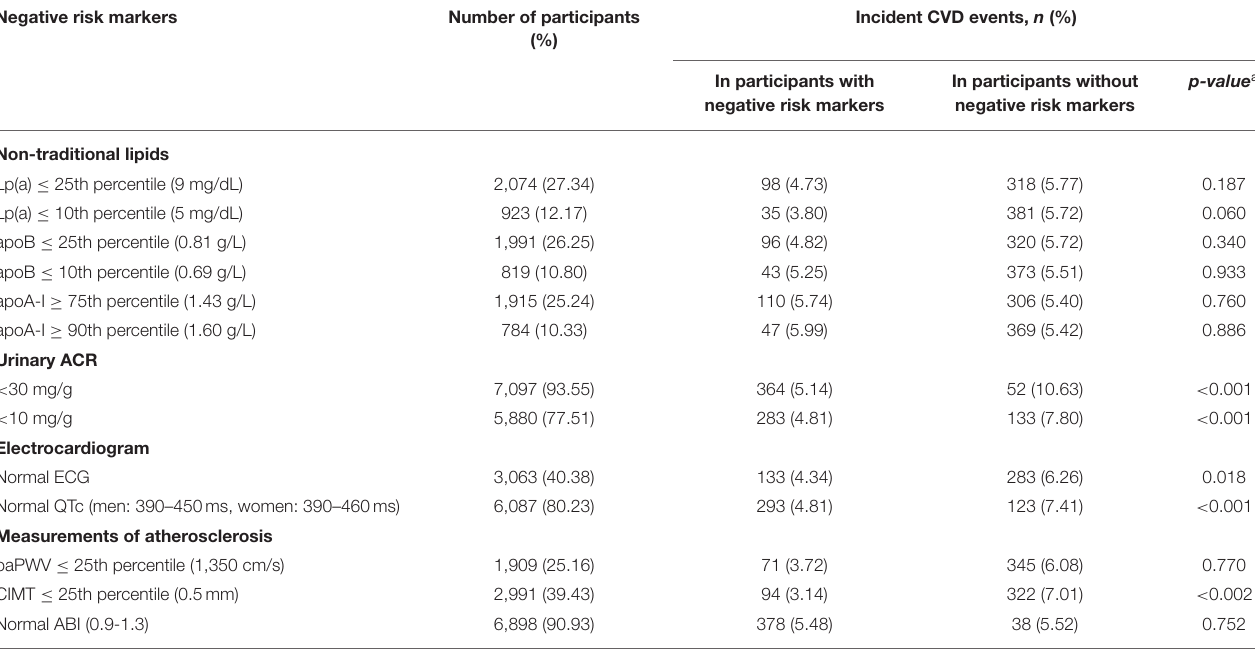
TABLE 2 | The development of CVD events in participants with and without negative risk markers. Negative risk markers Number of participants